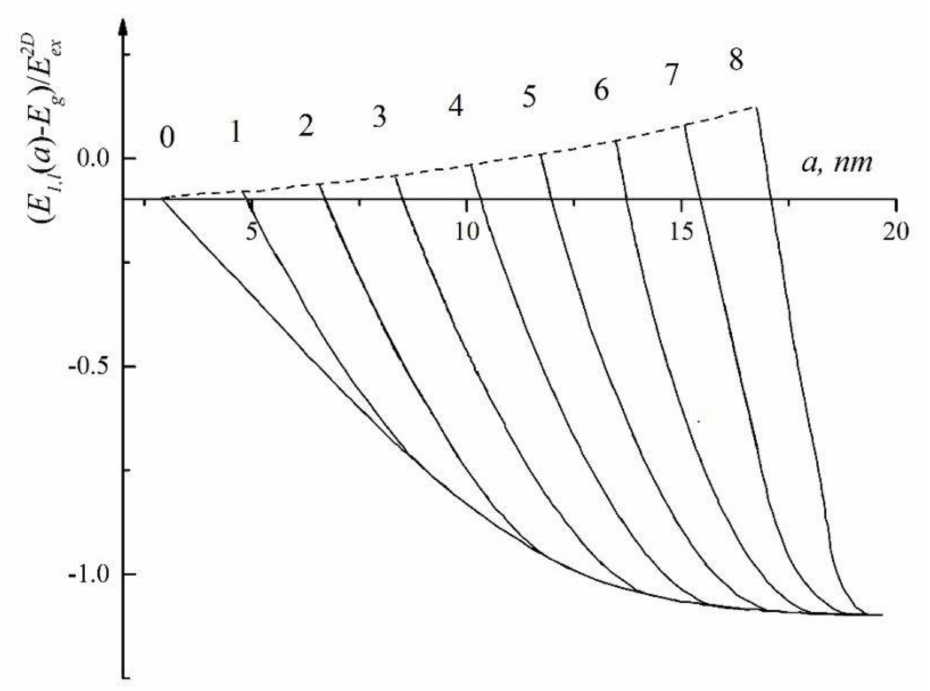
Figure 1. The dependence of the energy spectrum ( E 1, l ( a ) − E g ) of the exciton (from spatially separated electrons and holes) in the states ( n = 1 , l = 0, 1, 2, 3, 4, 5, 6, 7, 8) (where n and l —the principal and orbital quantum numbers of the electron) (solid line) on the a radius of the aluminum oxide QD, situated in the dielectric matrix (vacuum oil). The numbers at the curves indicate the value of l . The dashed lines indicate the boundaries of the spectrum of quasi-stationary states E max exciton. Here E g —bandgap of the aluminum oxide QD, E 2 D ex = 2.5038 eV—the binding energy of the ground state of the two-dimensional exciton (from spatially separated electrons and